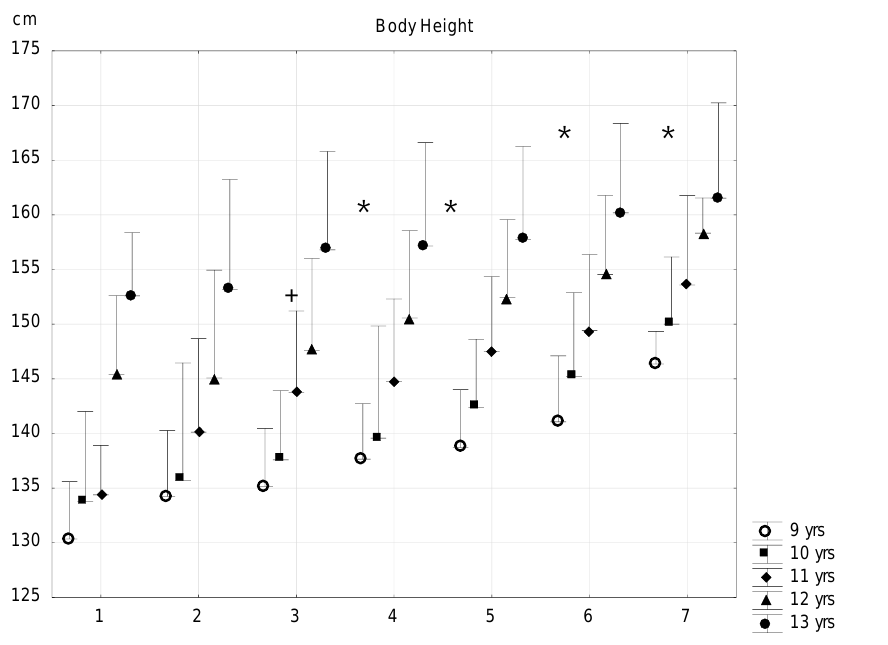
Figure 1. Relationship between body fat percentage and body height (mean + SD). 1—F% < 8.00; 2—F% = 8–11.99; 3—F% = 12.00–15.99; 4—F% = 16.00–19.99; 5—F% = 20.00–23.99; 6—F% = 24.00–27.99; 7—F% > 28; F% body fat percentage; * significant difference among subsequent groups; + significant difference in certain consecutive groups, p < 0.05.